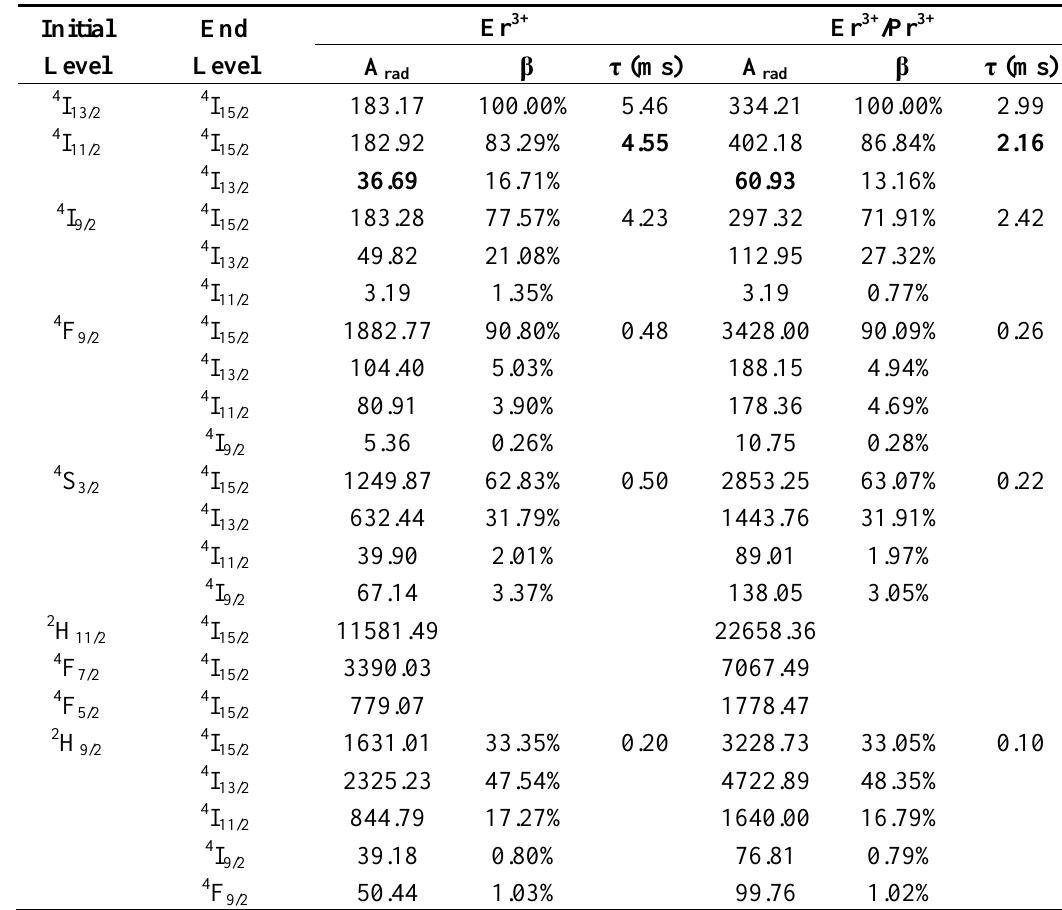
Table 2. Calculations of A Er 3+ /Pr 3+